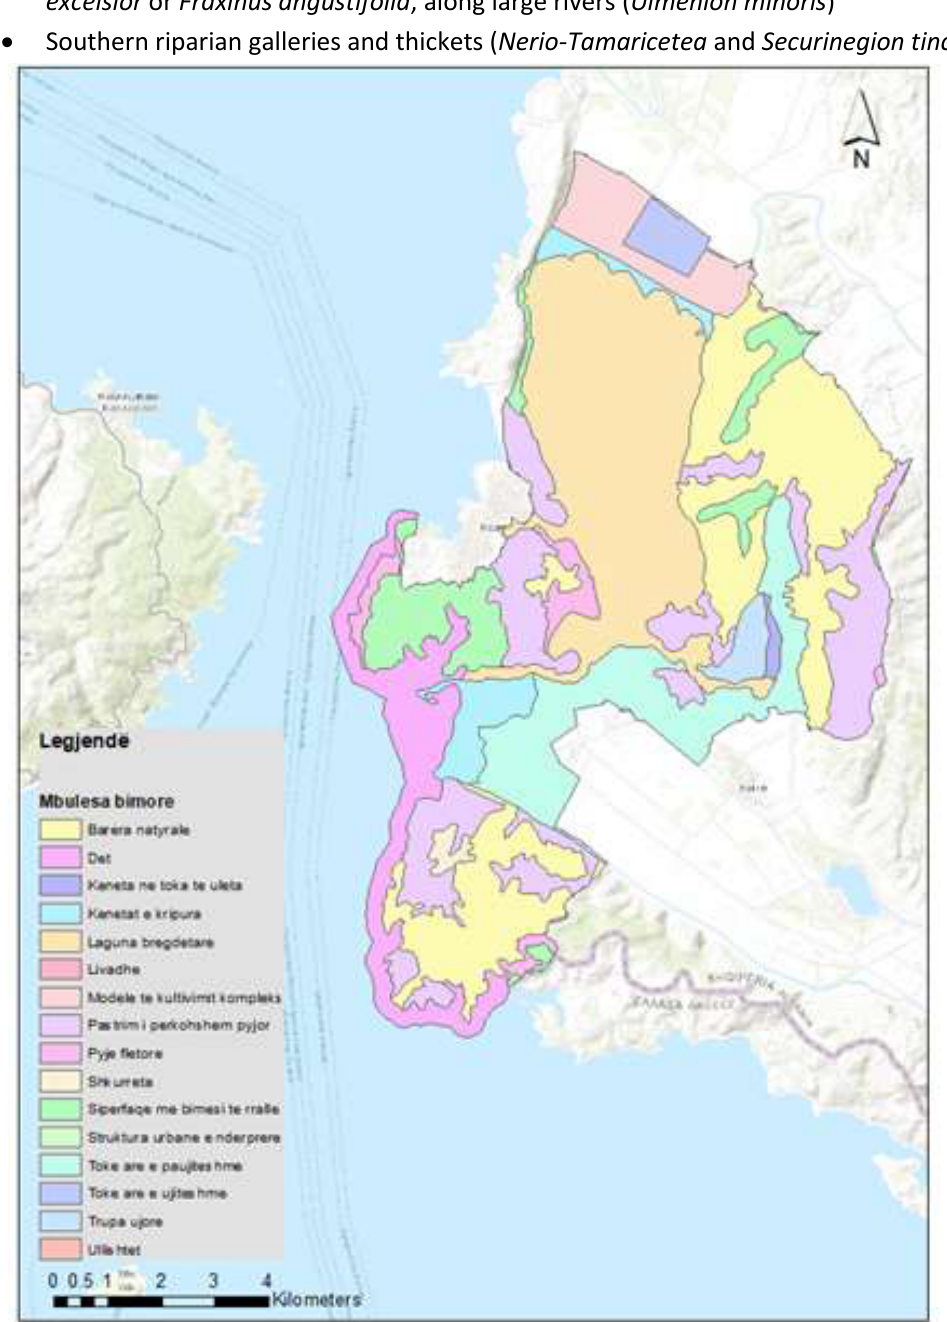
Figura 9: Harta e Mbulesës bimore në PK